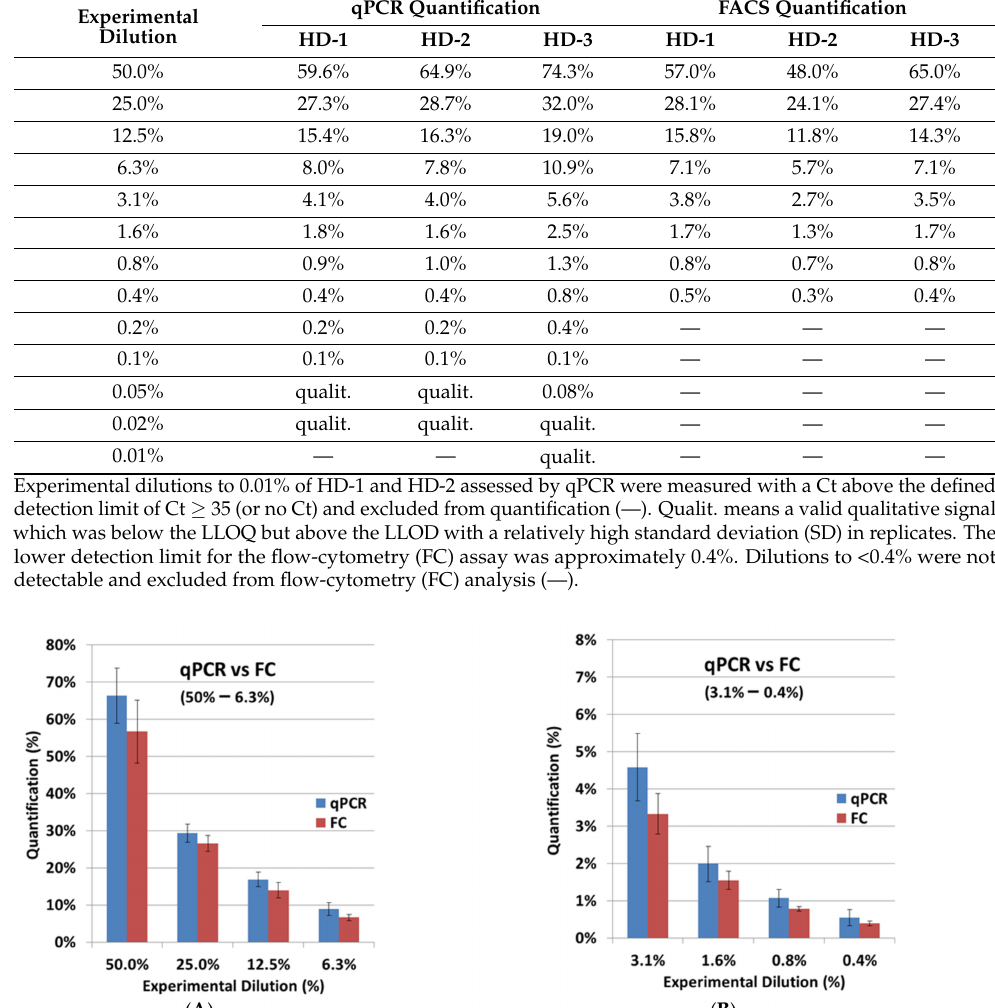
Table 2. qPCR and FACS results of genomic DNA from cell titration samples.